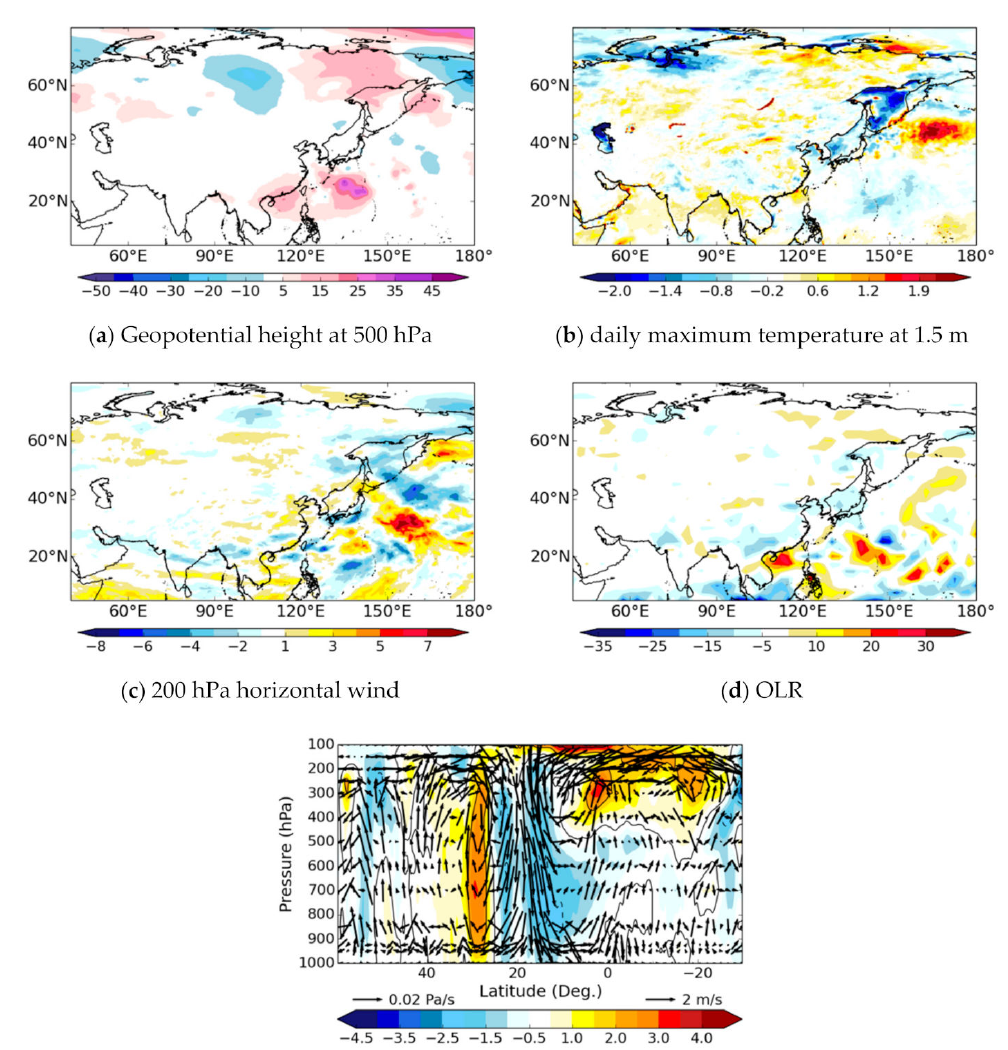
Figure 8. Di ff erences between averaged 7-day forecast CP and CTL experiments (CP-CTL) for ( a ) 500 hPa geopotential height (m), ( b ) daily maximum temperature at 1.5 m (K), ( c ) 200 hPa horizontal wind (m / s), ( d ) OLR (W / m 2 ) and ( e ) zonal winds as in Figure 7. Averaging period is 11–25 August